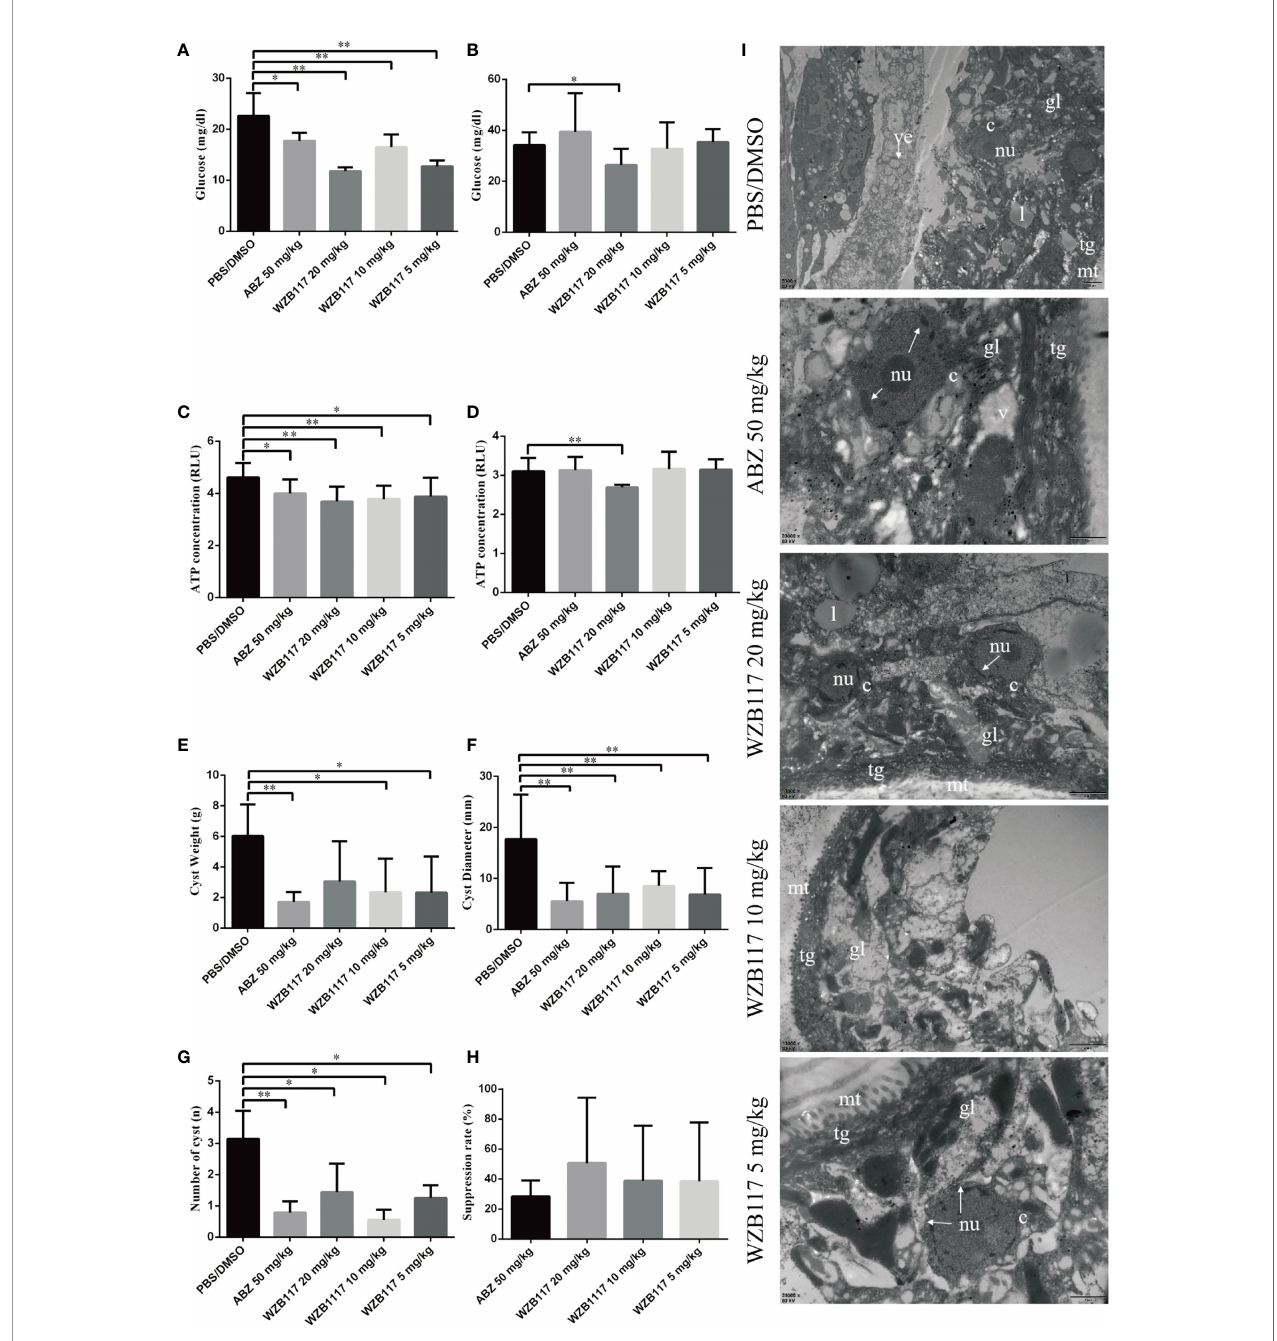
FIGURE 5 | WZB117 treatment effectively inhibits the growth of cysts and reduces glucose and ATP levels in E granulosus s.s.- infected mice. (A) Glucose content of cyst tissue in E granulosus s.s. -infected mice after WZB117 treatment for 28 days. (B) Glucose content in the cyst fl uid after WZB117 treatment for 28 days. (C) ATP content in the cyst tissue. (D) ATP content in the cyst fl uid. (E) Cyst weight in E granulosus s.s. -infected mice. (F) Cyst number in E granulosus s.s. -infected mice. (G) Cyst diameter in E granulosus s.s. -infected mice. * and ** show a statistically signi fi cant difference between the treatment group and the PBS/DMSO group at the indicated times (* P < 0.05, ** P < 0.01) (one-way ANOVA and nonparametric test of Kruskal-Wallis test) (n ≧ 5). (H) Ef fi cacy of 28-days treatments in E granulosus s.s. -infected mice. (I) Representative TEM images of cysts in E granulosus s.s. -infected mice. PBS/DMSO (1:1, v/v): control group; albendazole (ABZ) at 50 mg/kg was used as a reference anti-infective agent. gl, germinal layer; ll, laminated layer; tg, tegument; l, lipid droplet; mt, microtriches; nu, nucleus; c, cell; arrow, broken